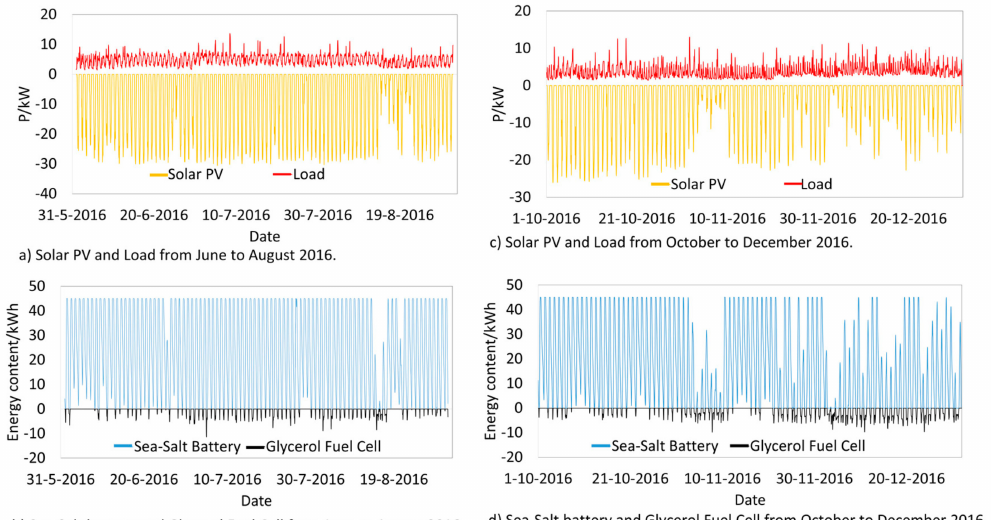
Figure 9. DEMkit results of an o ff -grid house in the Netherlands with hourly data with Solar PV, sea-salt battery and a glycerol fuel cell during the months of June to December 2016 showing ( a ) Solar PV and Load from June to August 2016, ( b ) Sea-salt battery SoC and glycerol fuel cell power from June to August 2016, ( c ) Solar PV and Load from October to December 2016, ( d ) Sea-salt battery SoC and glycerol fuel cell power from October to December 2016.